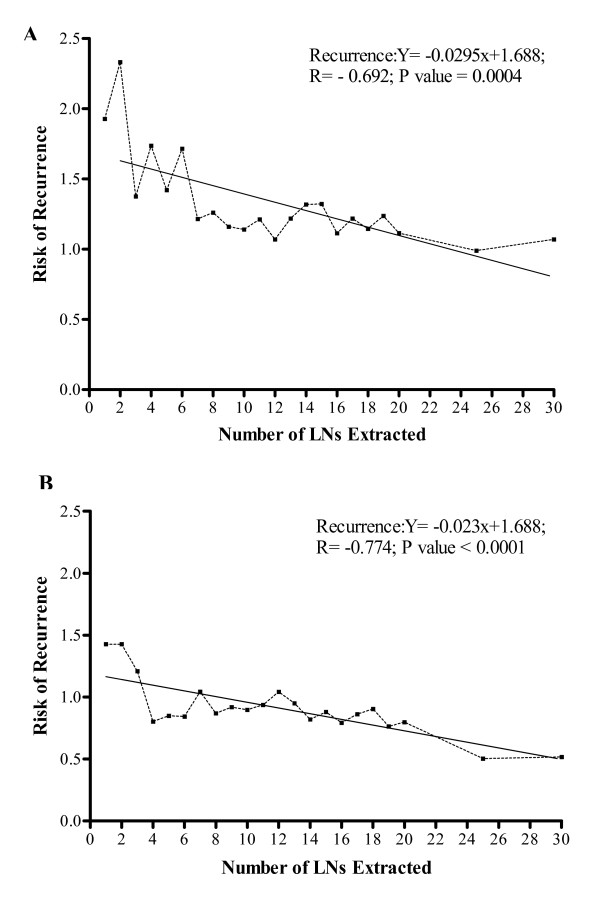
Overall risk of recurrence in Stage II (A) and III (B) colon cancers. Linear regression analysis of data from Stage II & III colon cancer patients demonstrates a decreasing risk of recurrence with increasing numbers of LNs identified. Note that Stage II & III patients with < 6 LNs harvested had the highest risk of recurrence; however, collection of 6 to 19 LNs resulted in a similar risk of recurrence. Collection of >20 LNs conferred a significantly reduced risk of recurrence.